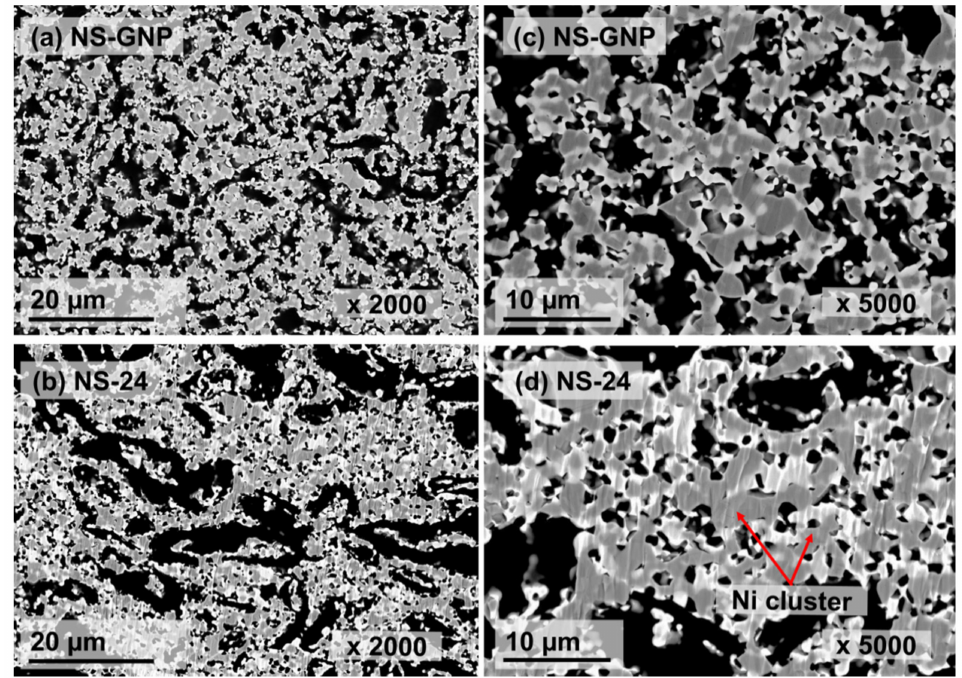
Figure 6. Cross-sectional FESEM images of Ni-SDC cermet anode after ion milling at different magnifications: ( a , c ) NS-GNP and ( b , d ) NS-24.